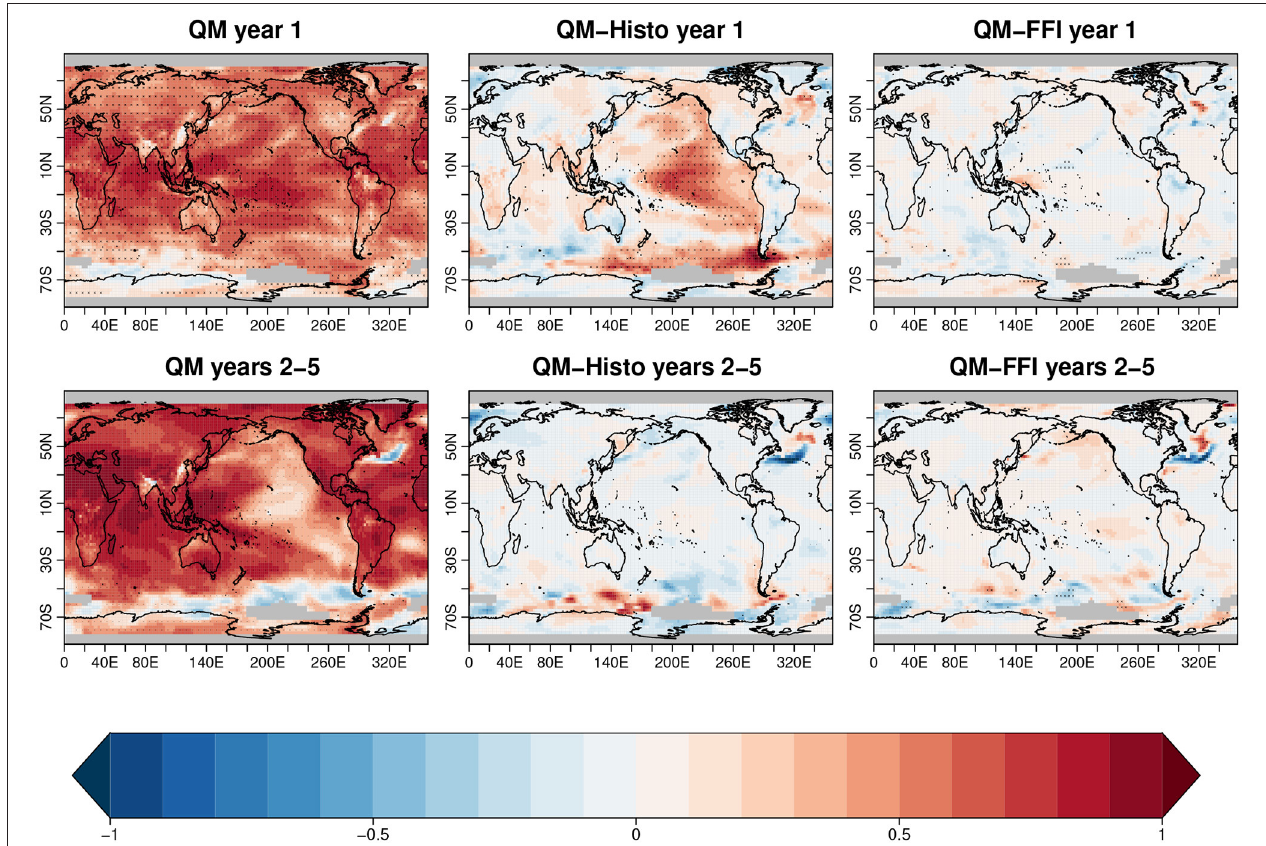
FIGURE 4 | Anomaly correlation for the surface temperature calculated against the GISTEMPv4 dataset. The first column represents the quantile matching (QM) skill in the first forecast year (top) and the 2–5 forecast years (bottom) . The middle column shows the difference between QM and Histo skill, and the third column the difference between QM and full-field initialization (FFI) skill. The black dots indicate regions of significant anomaly correlation (AC) (first column), and regions where the difference in AC is statistically significant with 95% confident level (second and third column).